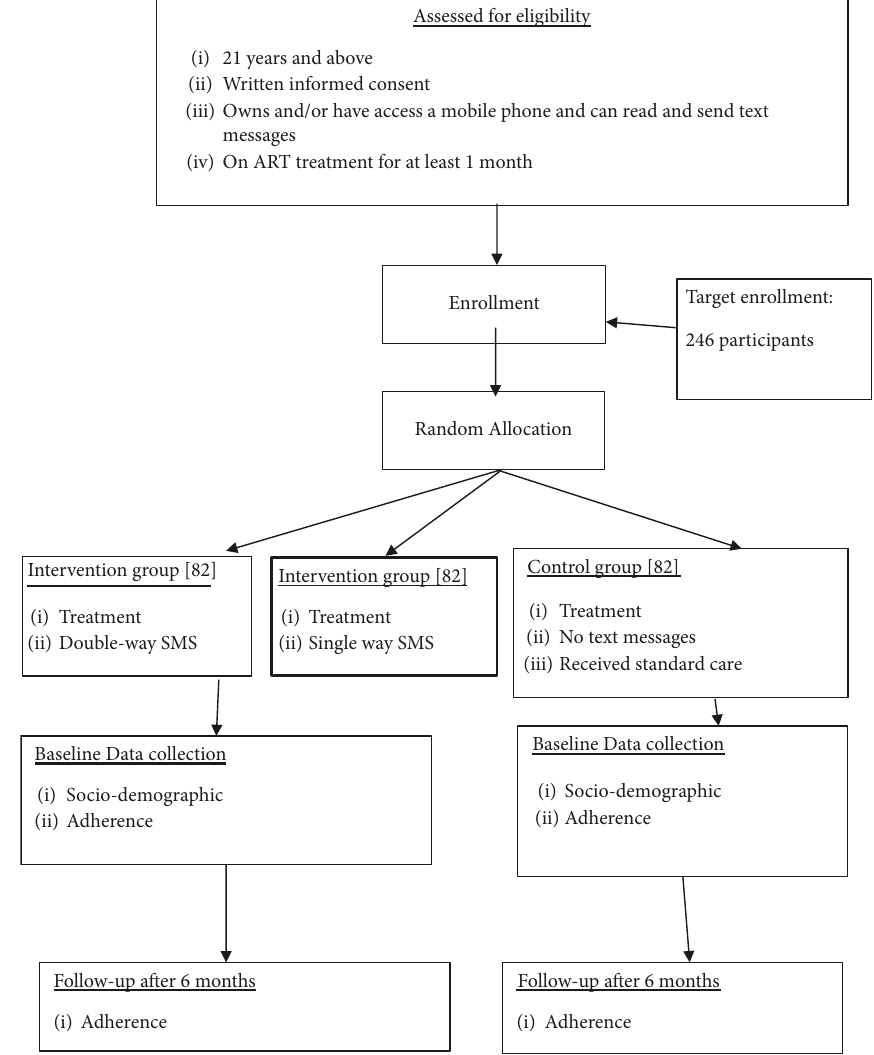
Figure 2: Flow chart showing recruitment and random allocation of the HIV participants in the intervention and control groups